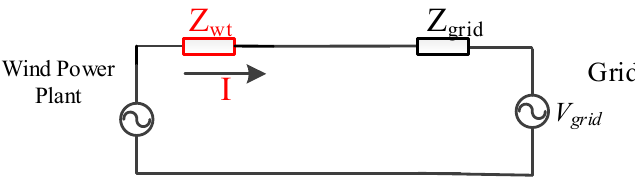
Figure 8. Aggregated wind power plant model connected to weak grid.